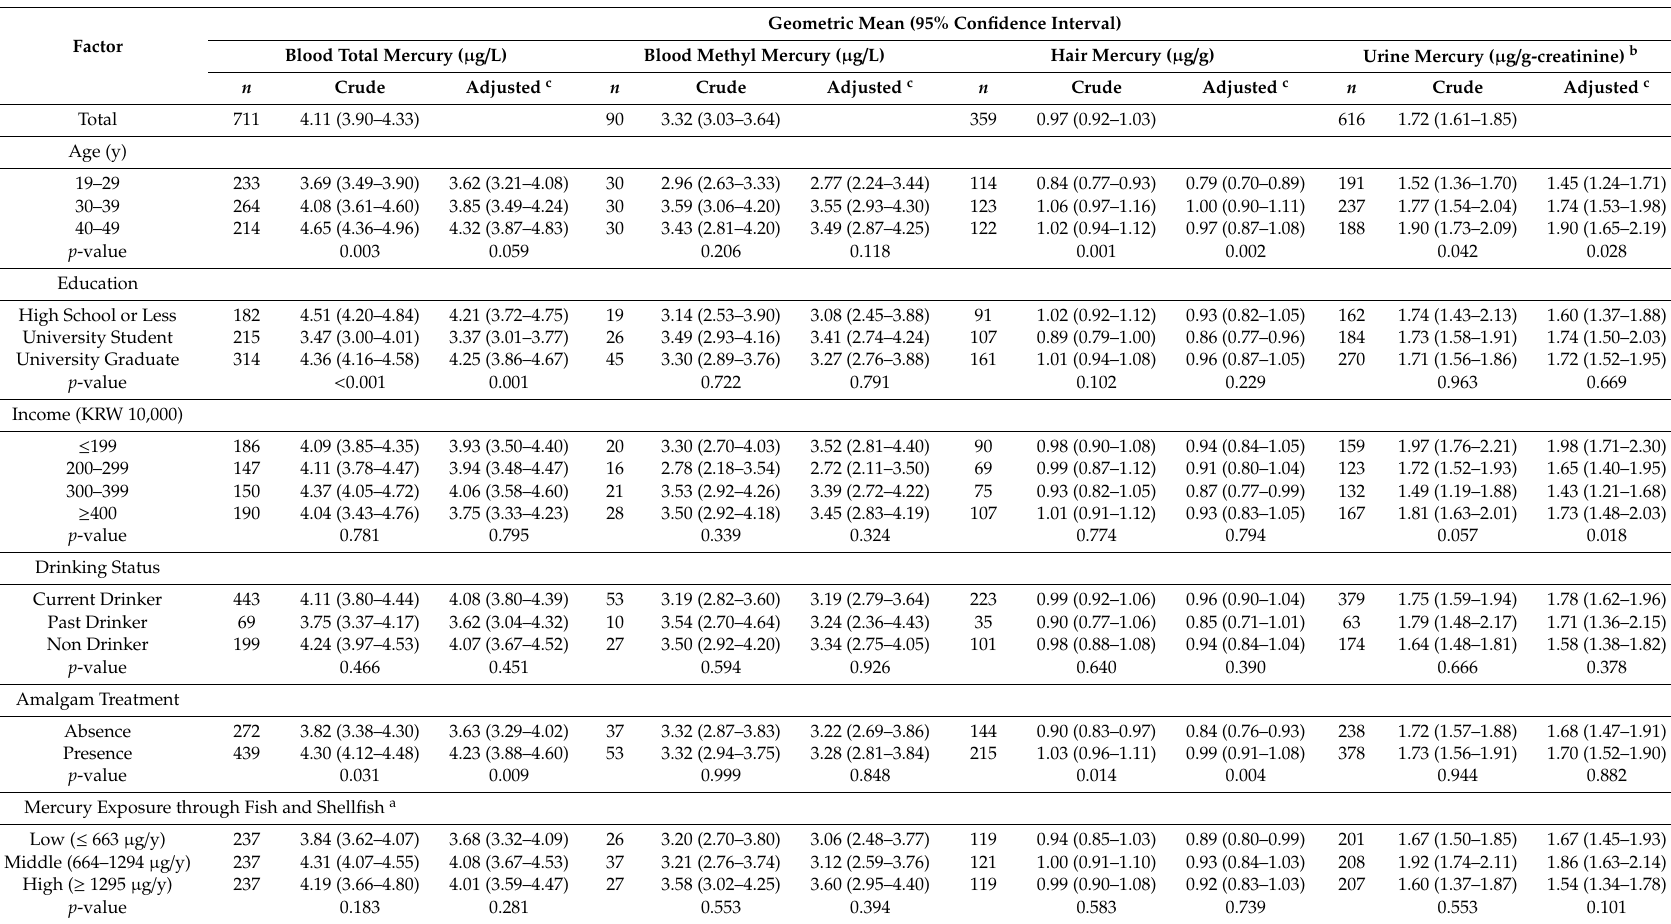
Table 1. Geometric means of the total blood, blood methyl, hair, and urine mercury